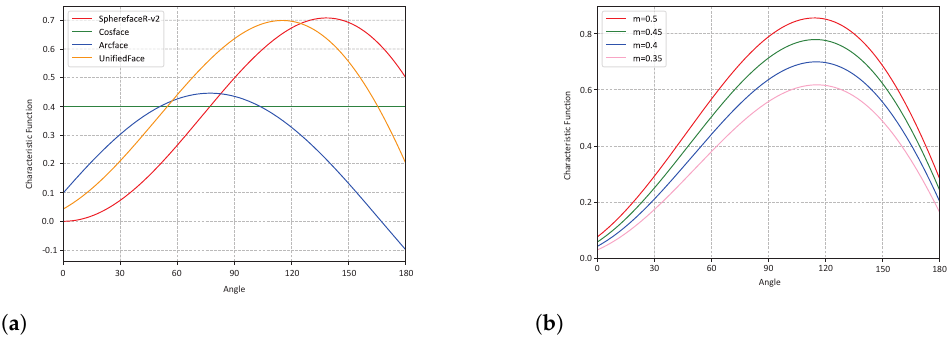
Figure 4. ( a ) Comparison between UnifiedFace and existing methods ( b ) Comparison of UnifiedFace at different m